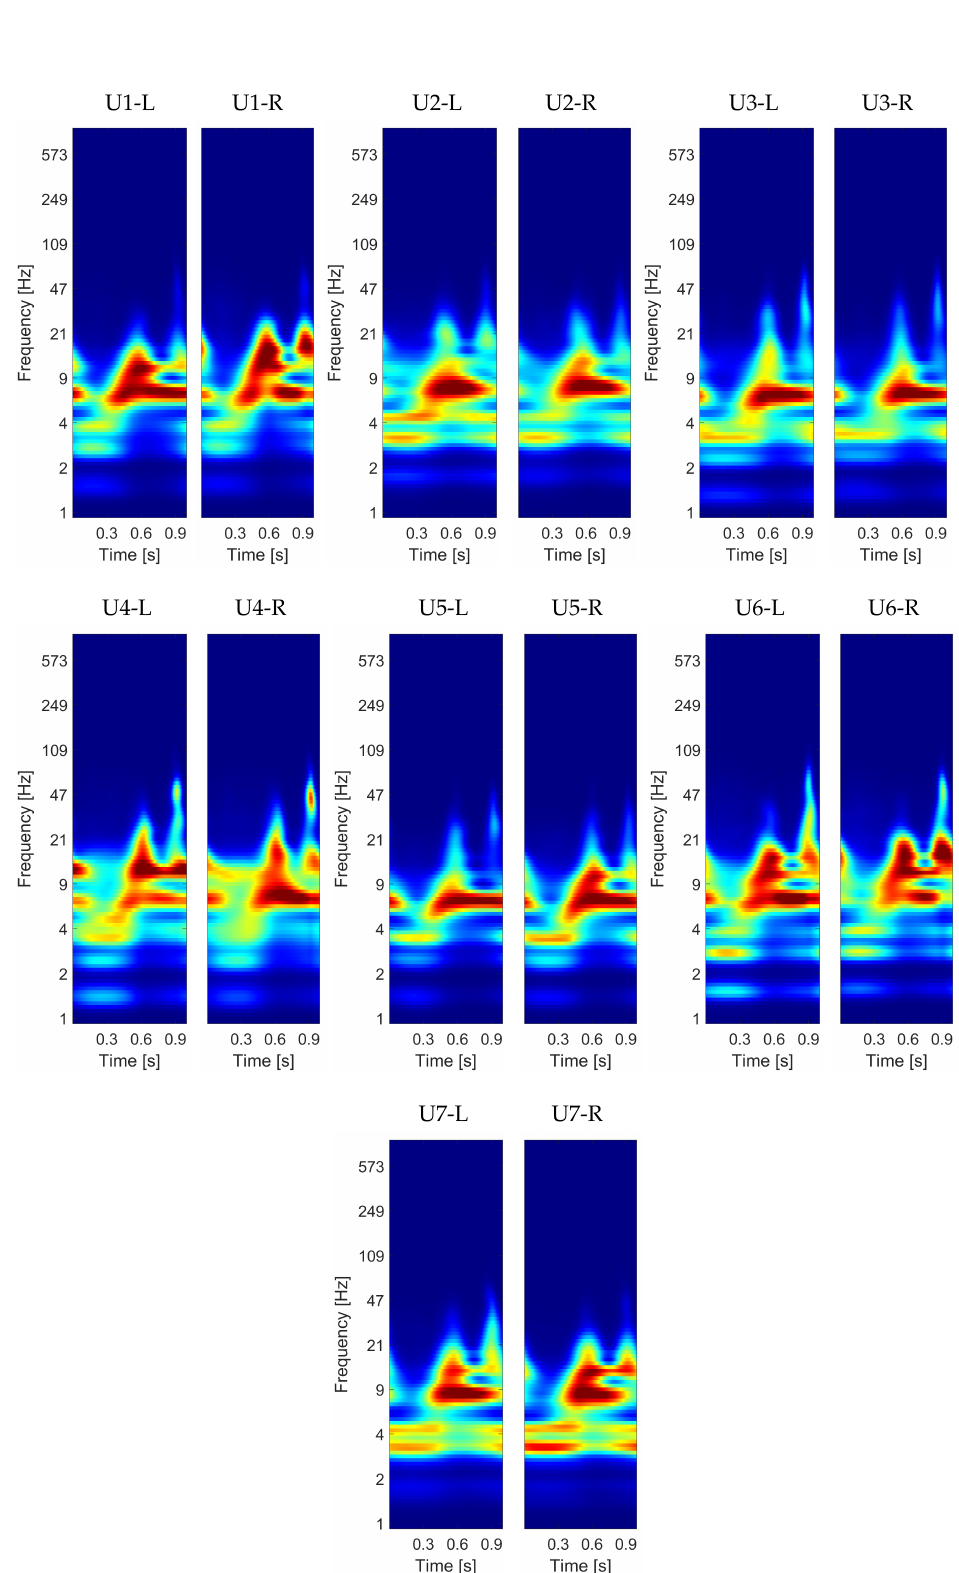
Figure 8. Averaged CWT spectrum considering all segmented cardiac cycles for the left (L) and right (R) carotid artery and for each